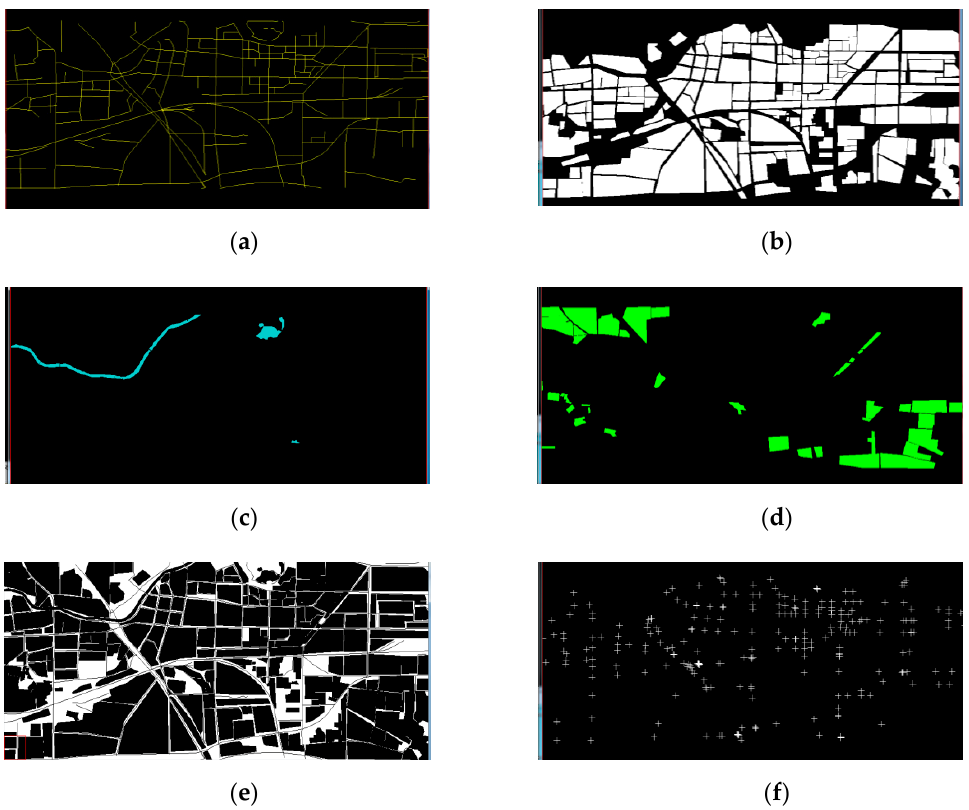
Figure 4. Classification maps of the study area. (a) Binary image of roads; (b) Binary image of buildings; (c) Binary image of water; (d) Binary image of vegetation; (e) Binary image of bare land; (f) Distribution of nodes.